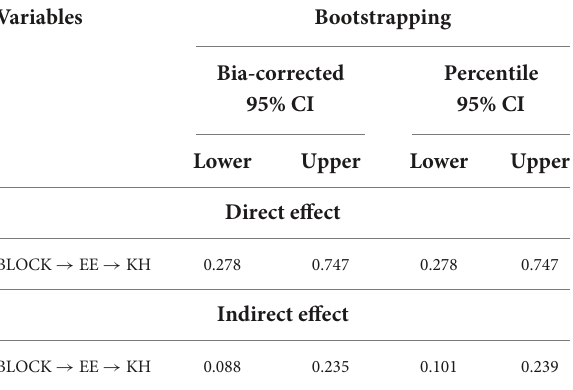
TABLE 4 Bootstrapping mediation effect test.